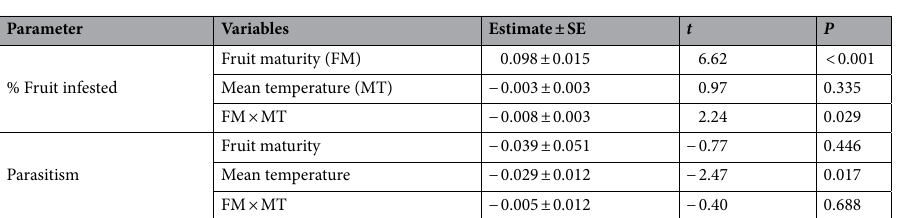
Table 3. Mixed Models analyzing the effects of fruit maturity (unripe vs. ripe), mean monthly temperature as well as the interactions of these two factors on fruit infestation rate and apparent parasitism in Western Cape, South Africa.